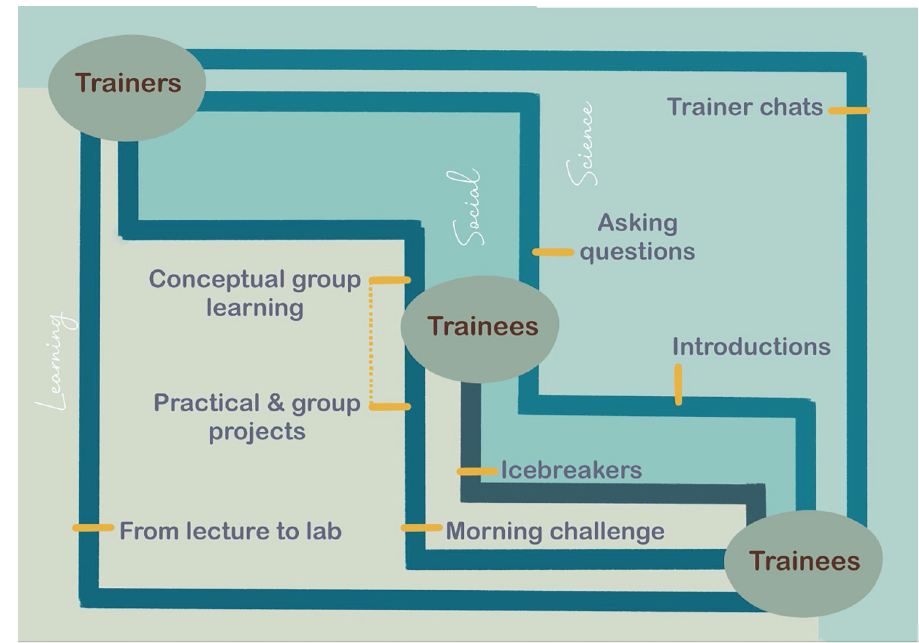
Fig 1. Interpersonal and intertopic interactions necessary for high-impact